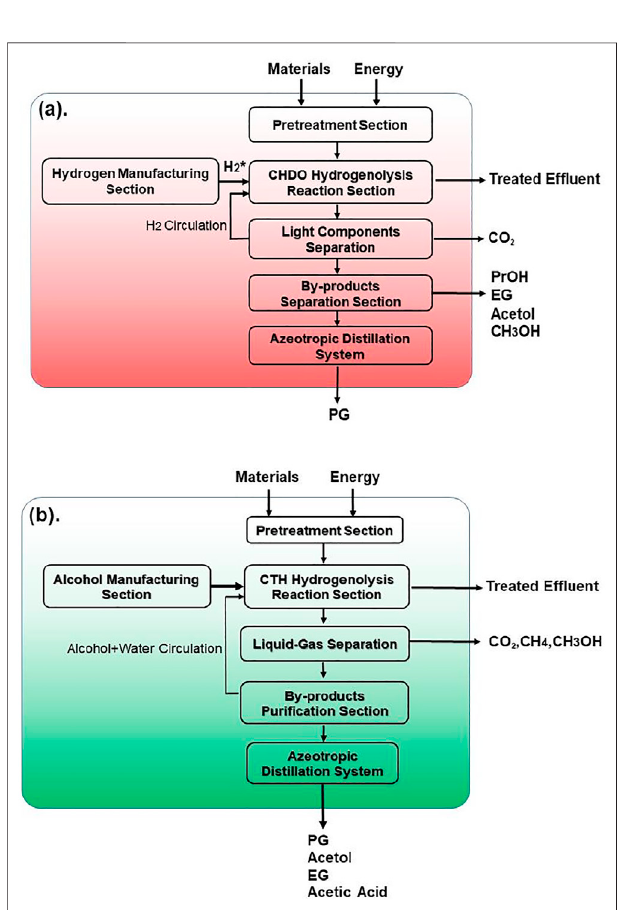
FIGURE 9 | The system boundaries for (A) CHDO and (B) CTH